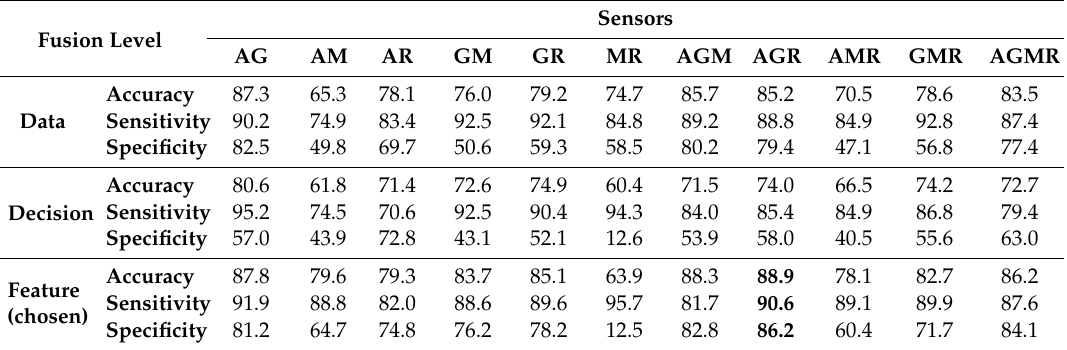
Table 2. Average testing accuracy (acc.), sensitivity (sens.), and specificity (spec.) achieved with a DL architecture with di ff erent information fusion levels (data-, decision-, and feature-level), and with multiple combinations of sensor data. LOSO evaluation (%). A—accelerometer, G—gyroscope, M— magnetometer, R—rotation vector sensor.